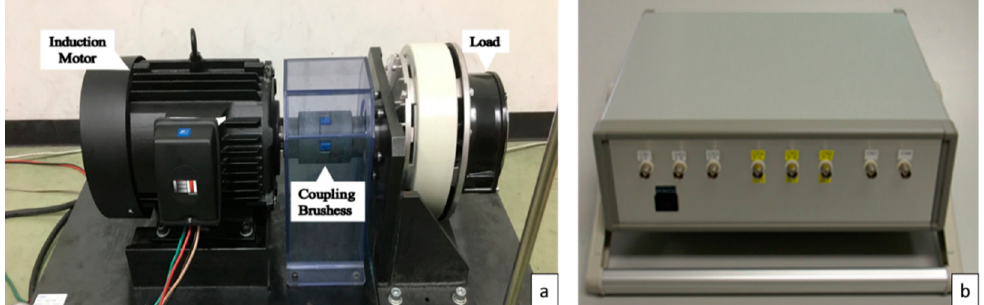
Figure 2. ( a ) Experimental setup; and ( b ) measurement equipment.